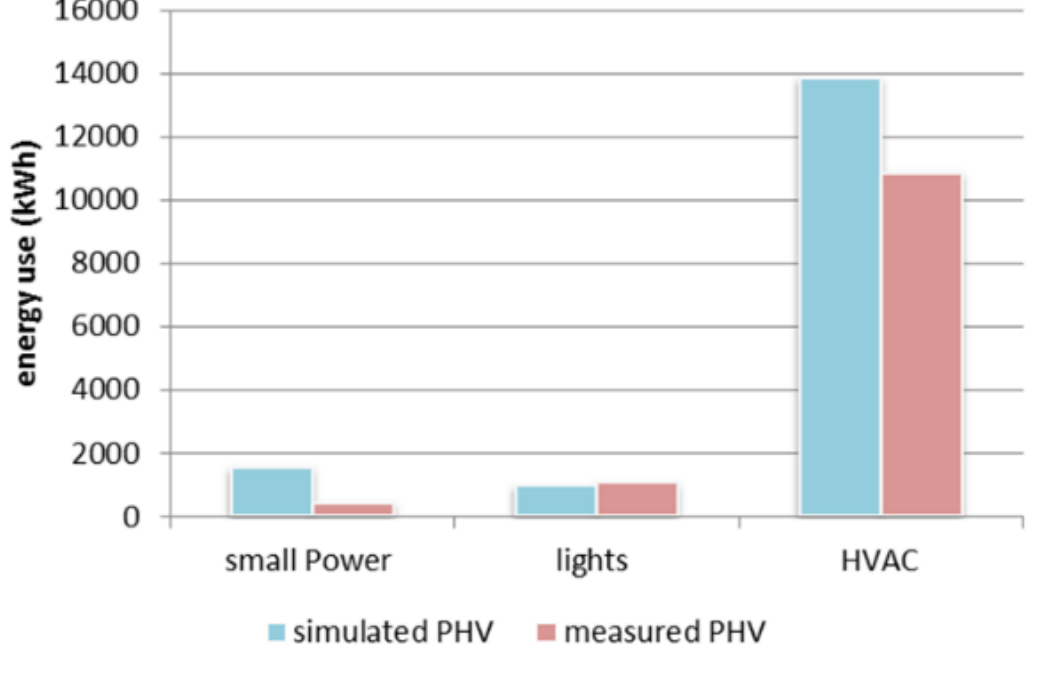
Figure 4. PHV simulated and measured energy